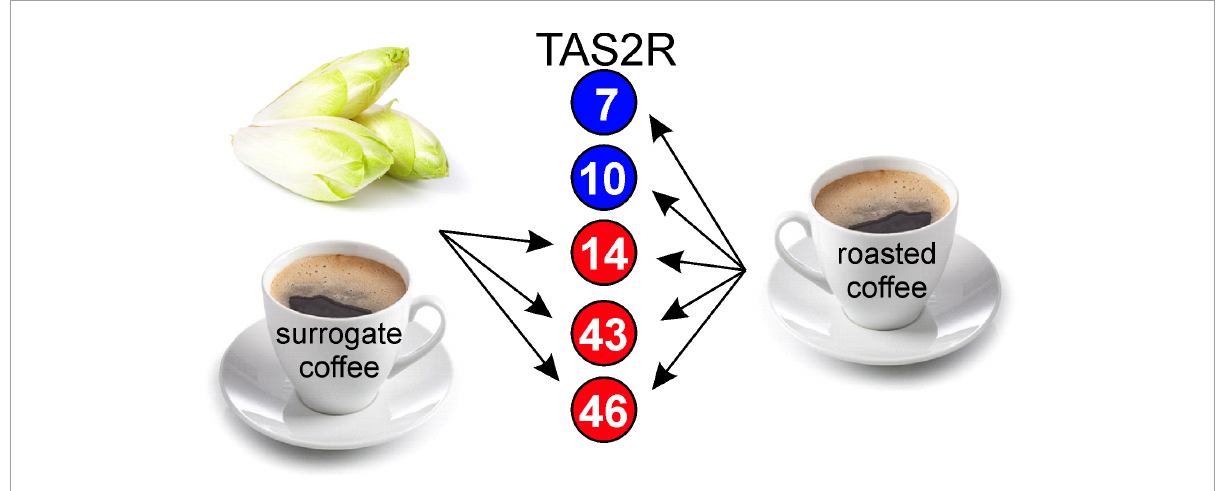
FIGURE4 Schematic of TAS2R profiles activated by chicory/surrogate coffee and roasted coffee. Numbers in circles correspond to TAS2R subtypes. Red circles label receptors activated by chicory and surrogate coffee, blue circles label receptors exclusively activated by roasted